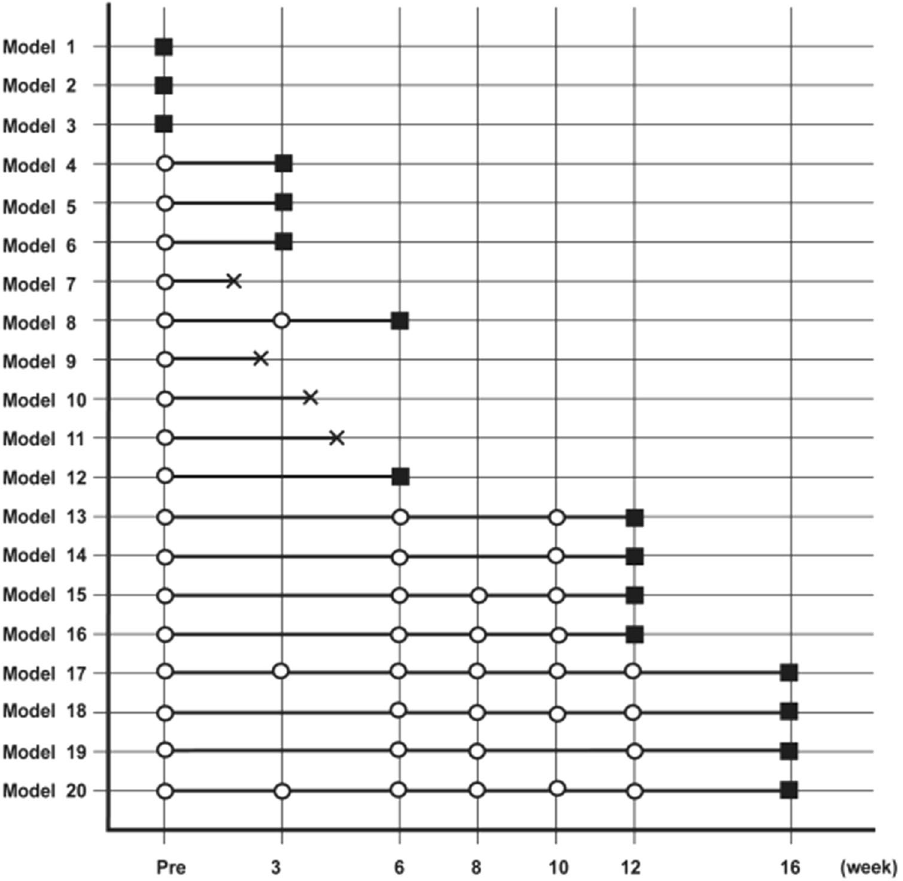
Figure 1. Experimental timeline and numbers of animals evaluated at each time point. All rabbits underwent cardiac magnetic resonance imaging (CMR) before and every 2–4 weeks after drug administration. Circles indicate scanning CMR; black squares indicate sacrifice after CMR scanning. Crosses indicate unexpected